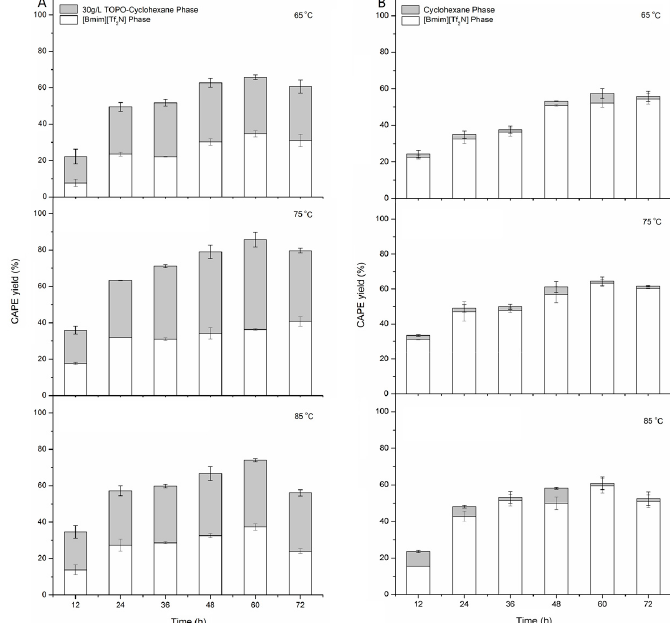
Figure 3. Comparison of CAPE yield from MC and PE via transesterification using equivoluminal 30 g/L TOPO-cyclohexane/[Bmim][Tf 2 N] ( A ) and cyclohexane/[Bmim][Tf 2 N] ( B ) at different temperatures. The upper histogram shows the yield of CAPE in the solvent phase; the lower histogram shows the yield of CAPE in the ionic liquid (IL phase); and the total CAPE yield is the sum of the upper and lower yields. Conditions: mass ratio of MC to Novozym 435 = 1:20, molar ratio of MC to PE = 1:15, MC concentration = 10 g/L, 180 rpm for 72 h. Each value is expressed as the mean ± standard deviation ( n =